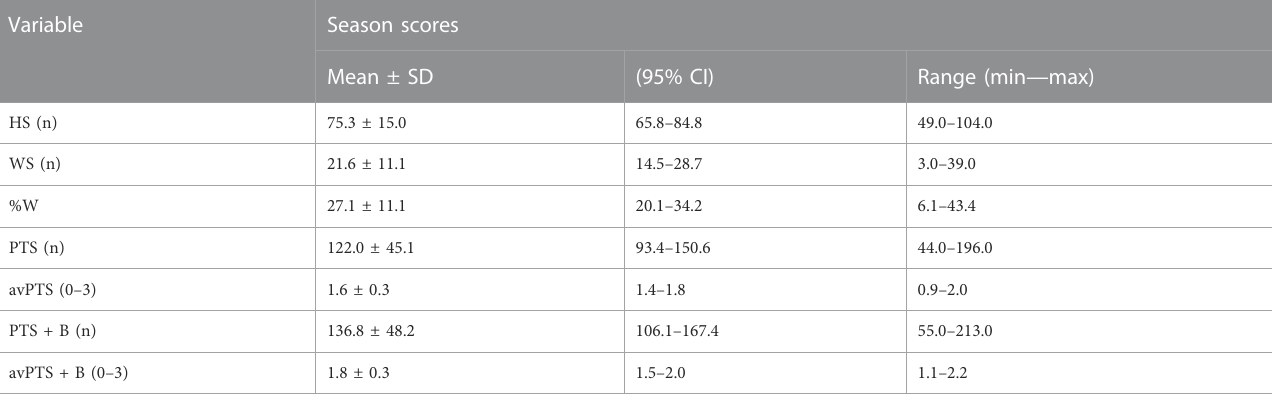
TABLE 1 Season scores mean ± standard deviation, 95% CI and range (min-max) of riders determining the sport level of the tested athletes through scores obtained during all heats in the competitive season.